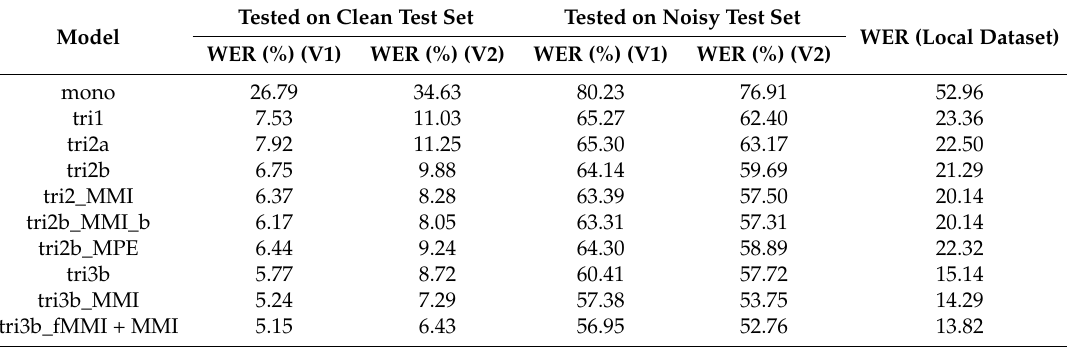
Table 3. WER of models trained on clean data. MMI, maximum mutual information; MPE, maximum phone